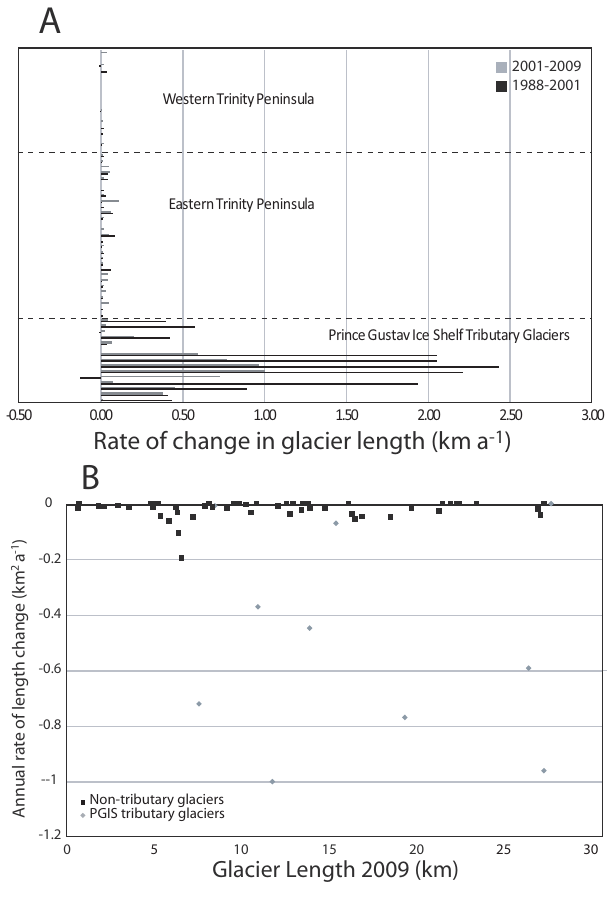
Fig. 6. Tidewater glacier length. (A) Rates of glacier length change in tidewater glaciers on Trinity Peninsula. (B) Scatter plot showing poor correlation between 2009 glacier length and length